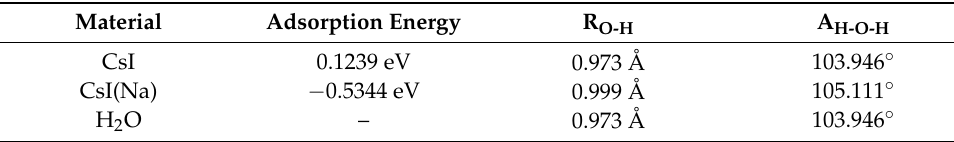
Table 2. The adsorption energy of the CsI and CsI(Na) crystals.